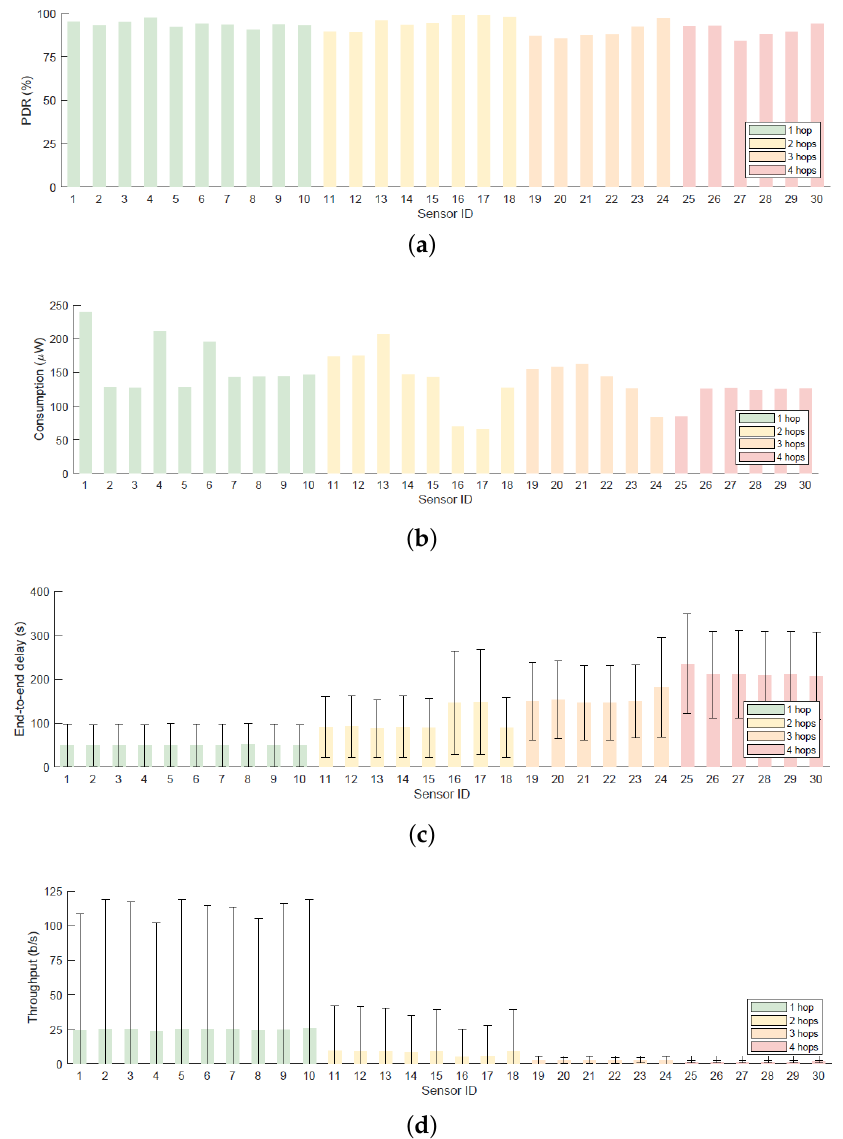
Figure 11. Results for the Testbed2 ( a ) PDR, ( b ) power consumption, ( c ) average end-to-end delay and ( b )